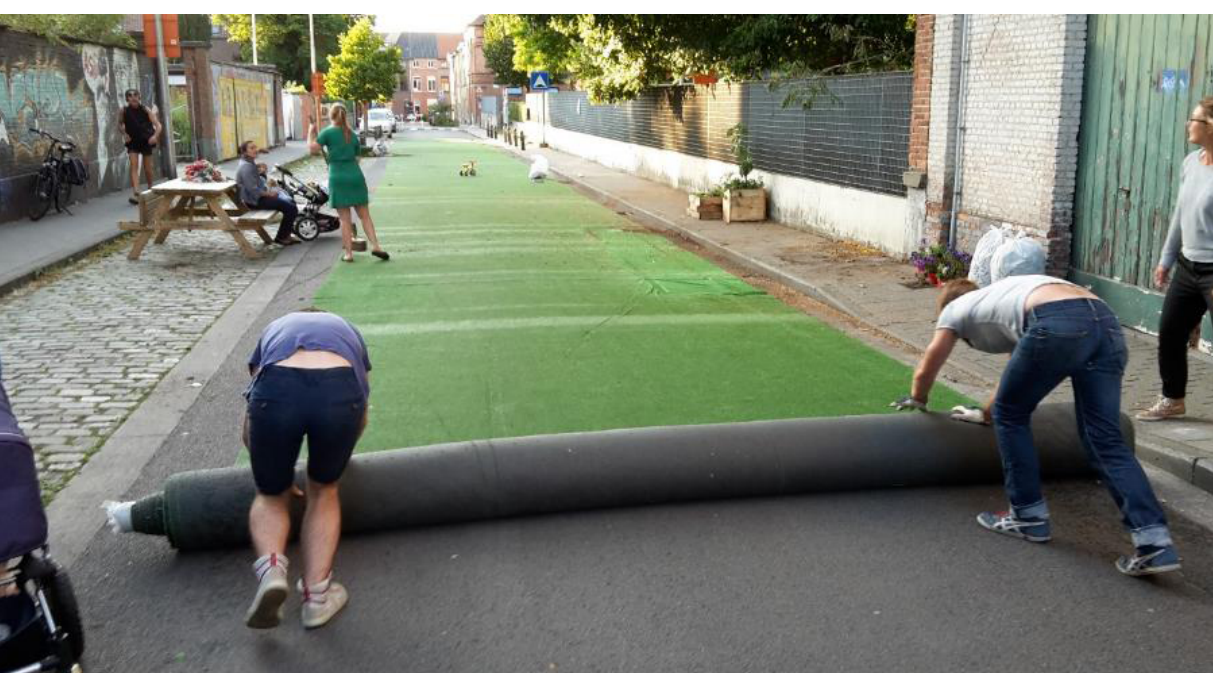
Figure 2. The Living streets as local experiments for car free